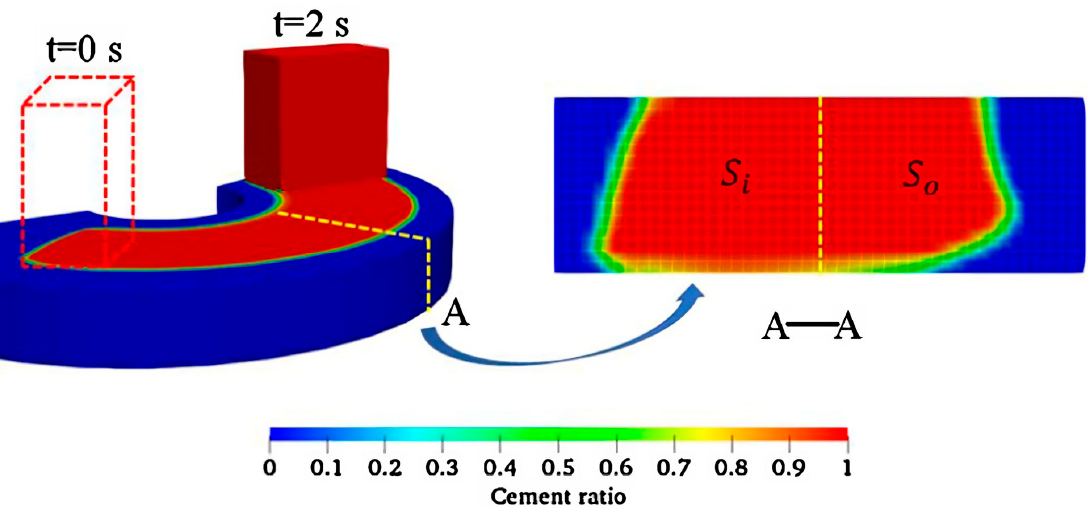
Figure 2. Example of simulation result. Cross-section A-A illustrating inner side ( S i ) and outer side ( S o ) cross-sectional area of a filament extracted from Ref. [8].